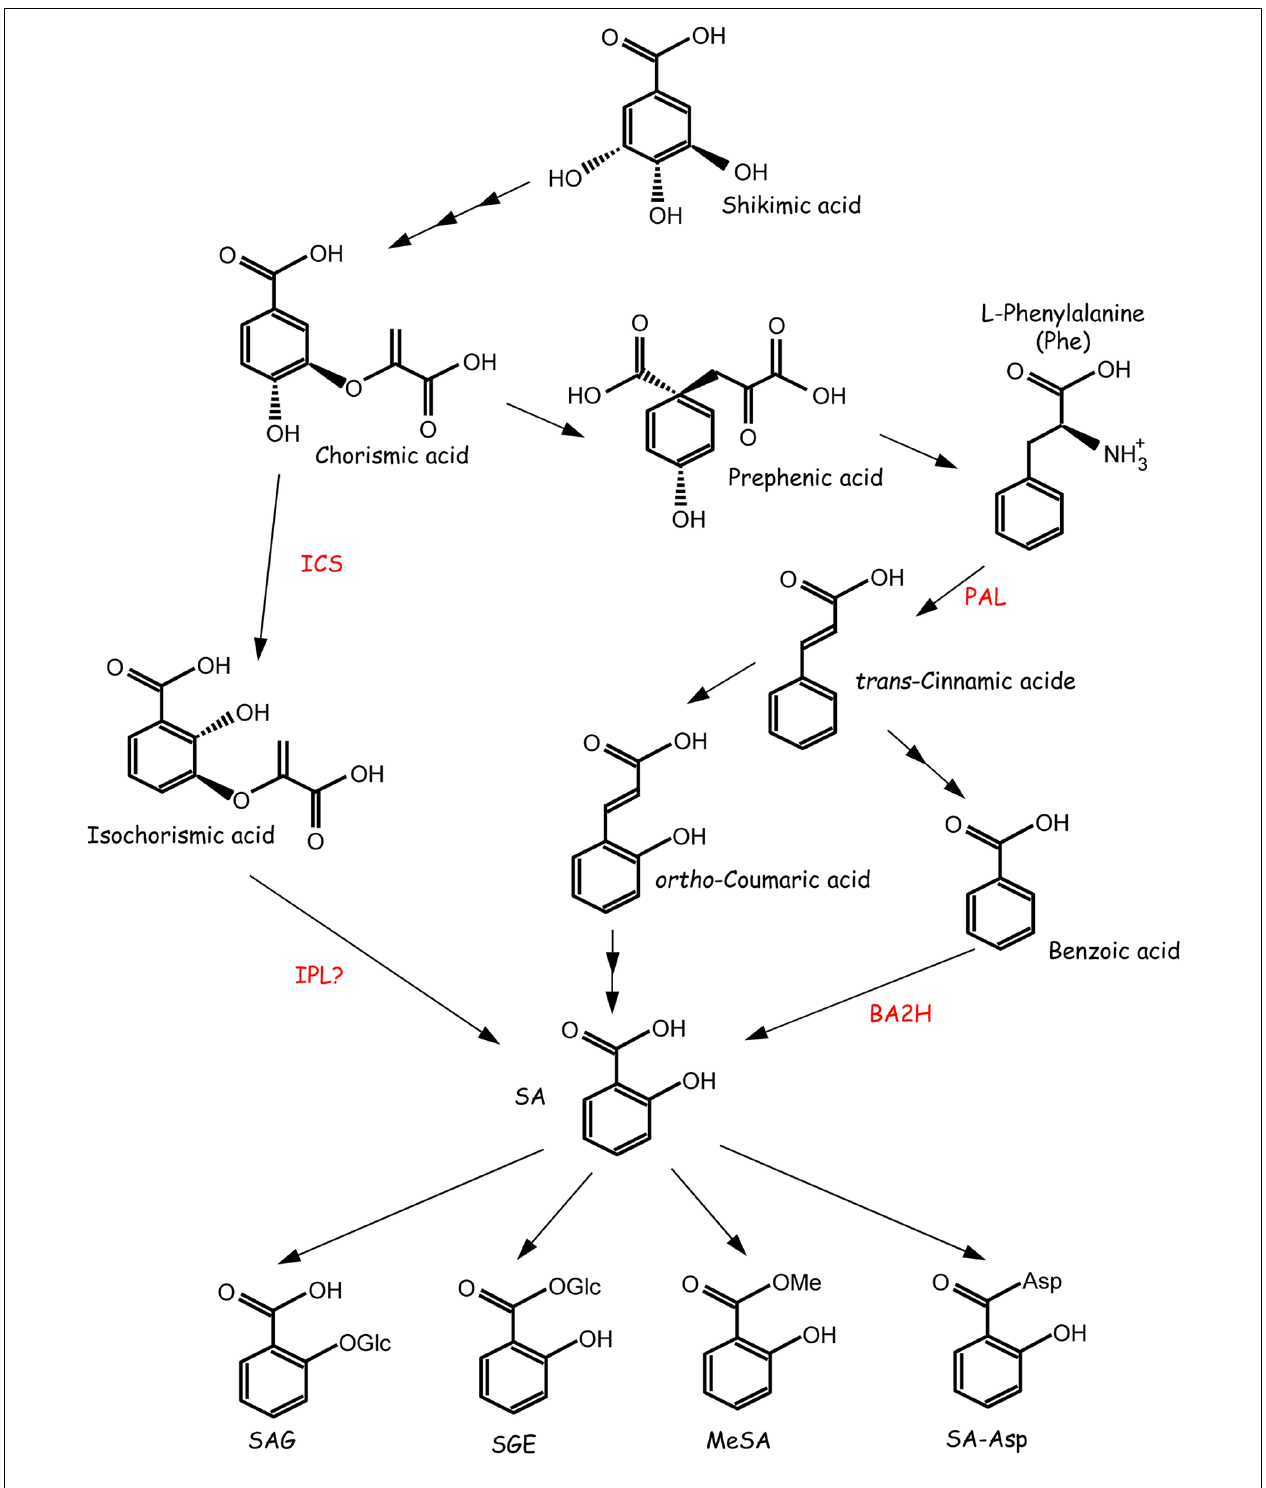
FIGURE 1 | Proposed pathways for SA biosynthesis and SA modification. SA is synthesized through the isochorismate (ICS) or phenylalanine ammonia-lyase (PAL) pathways. SA is also converted into several forms. BA2H, benzoic acid-2-hydroxylase; IPL,